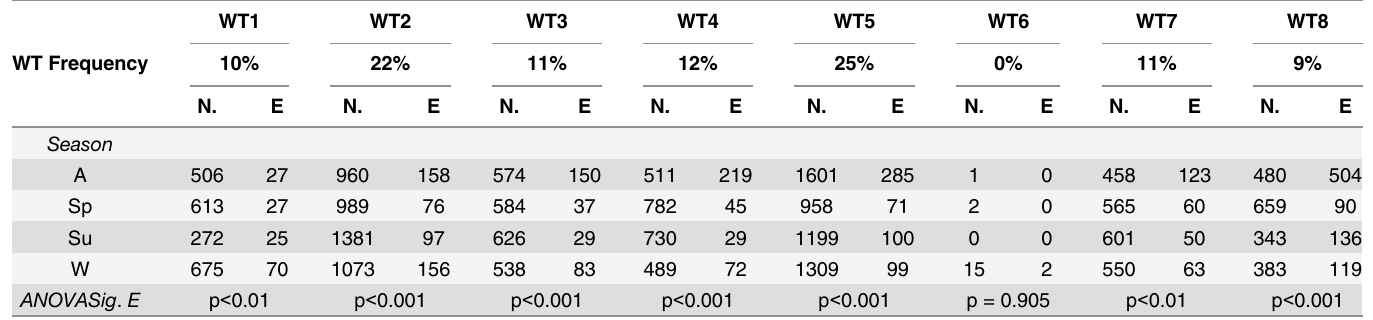
Table 3. Seasonal distribution of weather types and flood and landslide events from 1948 to